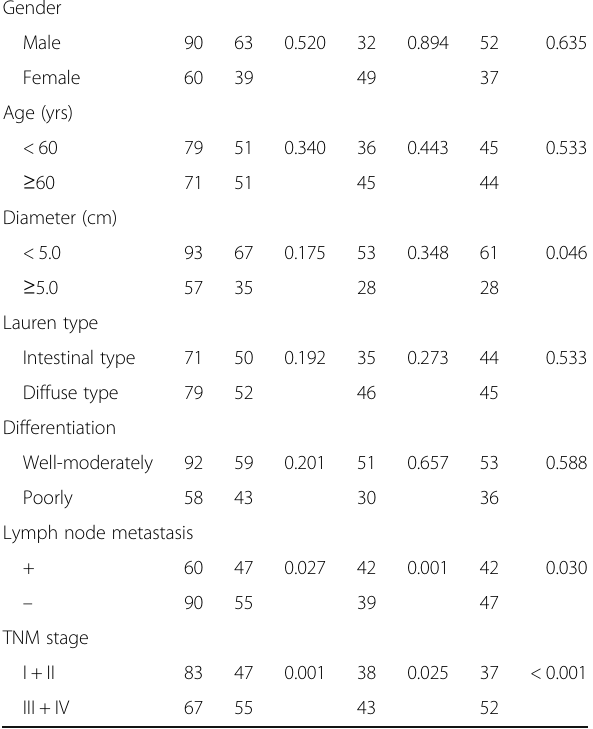
Table 2 Relationship between TLR4, MD-2, and CXCR7 protein expression and clinicopathological parameters in gastric